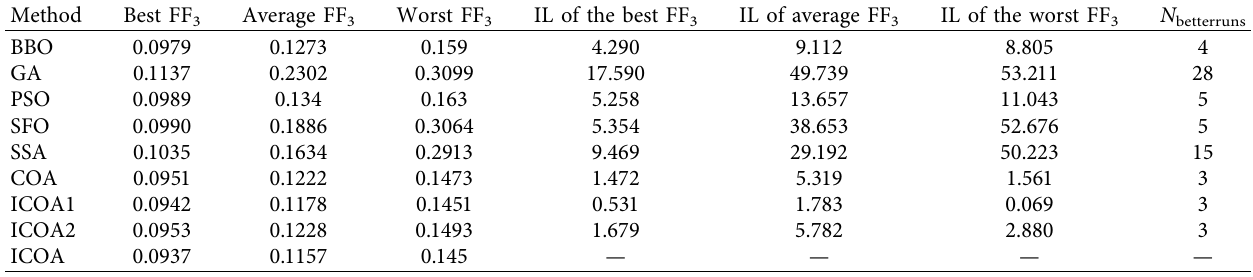
Table 8: The comparison among nine methods of the IEEE 33-bus distribution network for the third case. Method